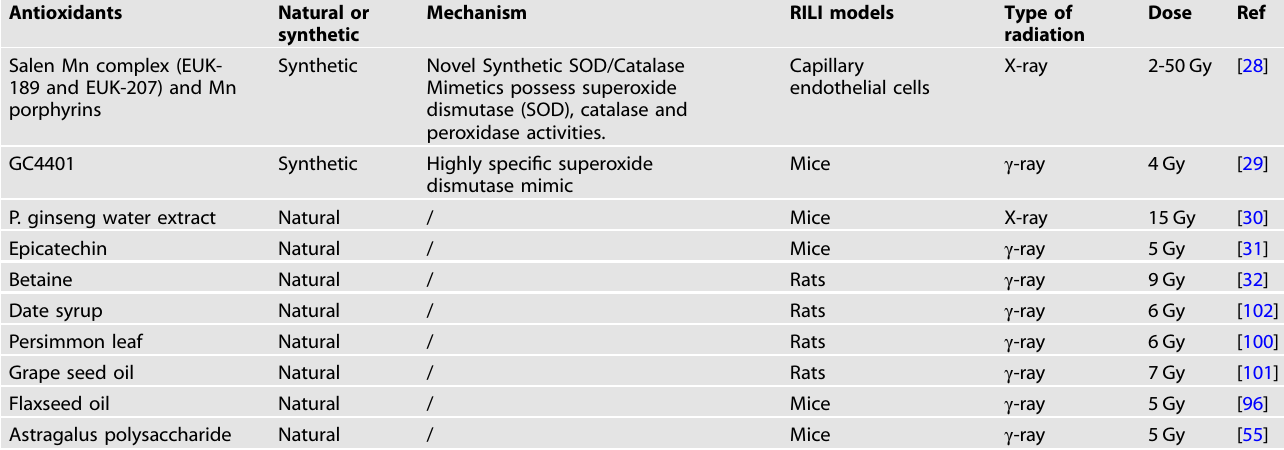
Table 2. Antioxidants alleviate the progression of RILI.